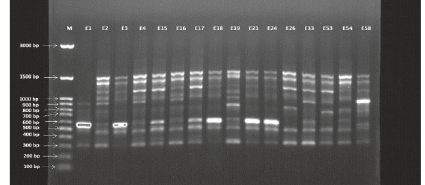
LNLNLNLNLNLNLNLNLNLNLNLNLNLNLNLNLNLNLNLNLNLNLNLNLN